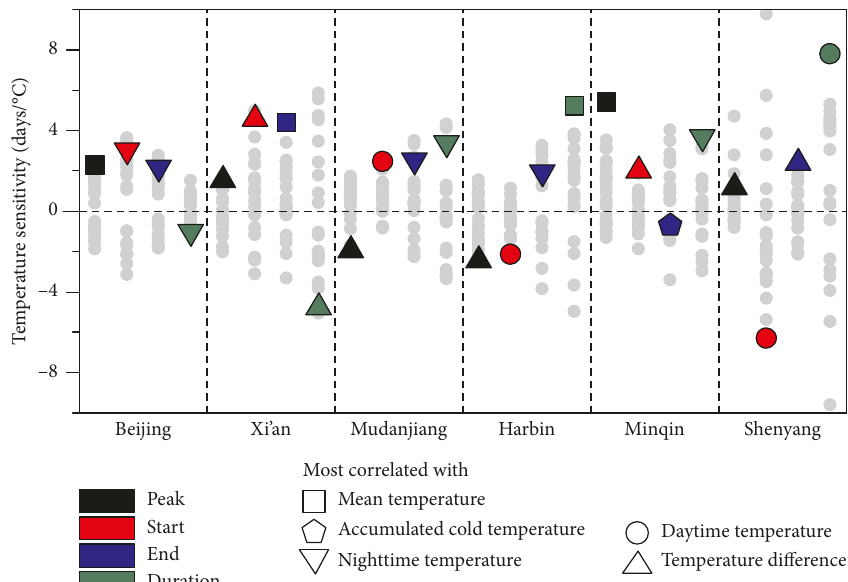
Figure 8: The sensitivity of the peak, start, end, and duration of the leaf coloring season (LCS) at six sites to temperature parameters. The colors in figures show the sensitivity of the peak, start, end, and duration of LCS to the most correlated temperature parameters, and the grey dots show the sensitivity of the peak, start, end, and duration of LCS to the other temperature